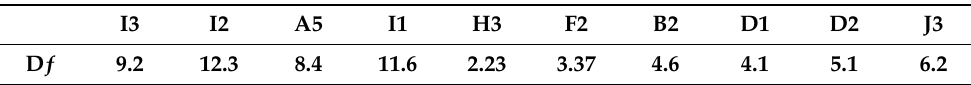
Table 1. Degree of degradation of sample areas.